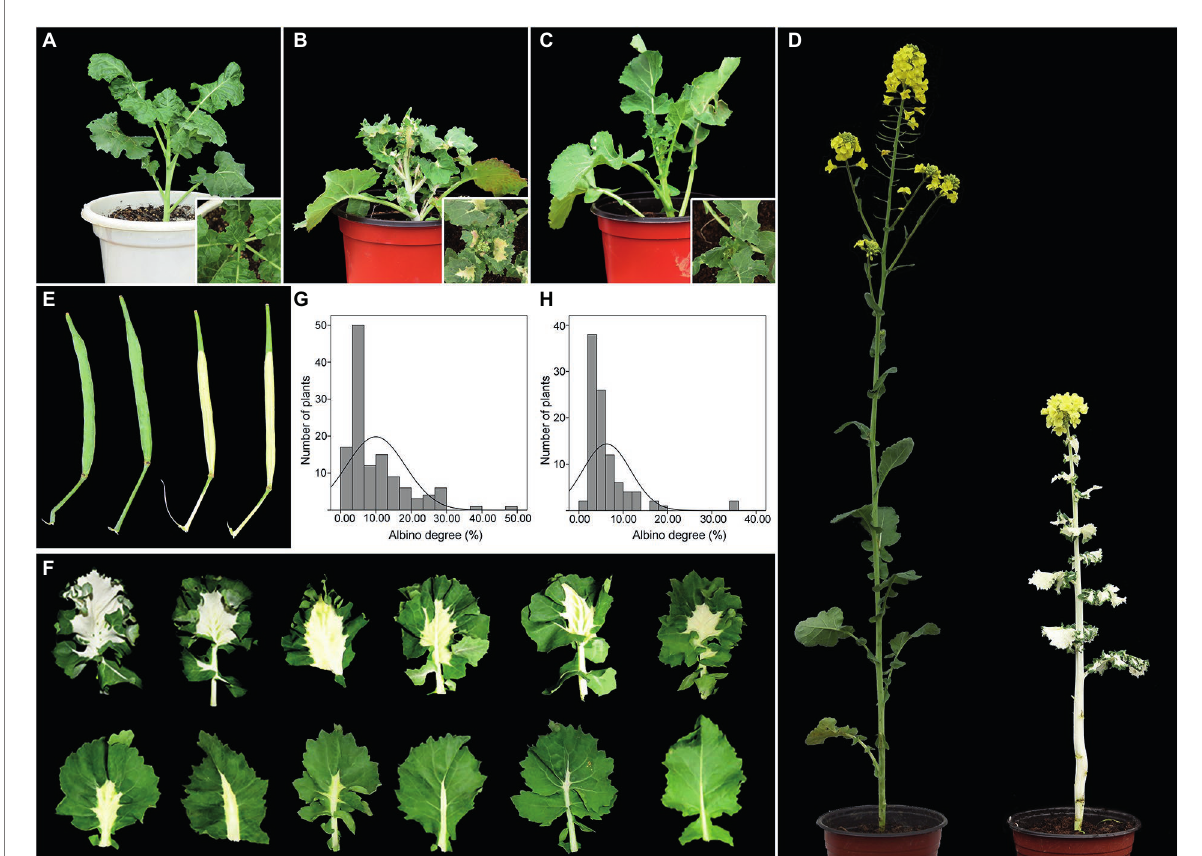
FIGURE 1 Phenotypic characterization of B. napus lines G7097 and W7105. (A) Field-grown G7097 (GL). (B) Field-grown W7105 (WL). (C) Greenhouse-grown W7105 (WGL). (D) Field-grown GL (left) and WL (right) at the flowering stage. (E) Siliques of GL (left) and WL (right). (F) Phenotype of the leaves of BC 1 F 2 plants. (G) Frequency distribution of albino-part/leaf area ratio in the BC 1 population ( n = 124). (H) Frequency distribution of albino-part/leaf area ratio in the BC 1 F 2 population ( n =